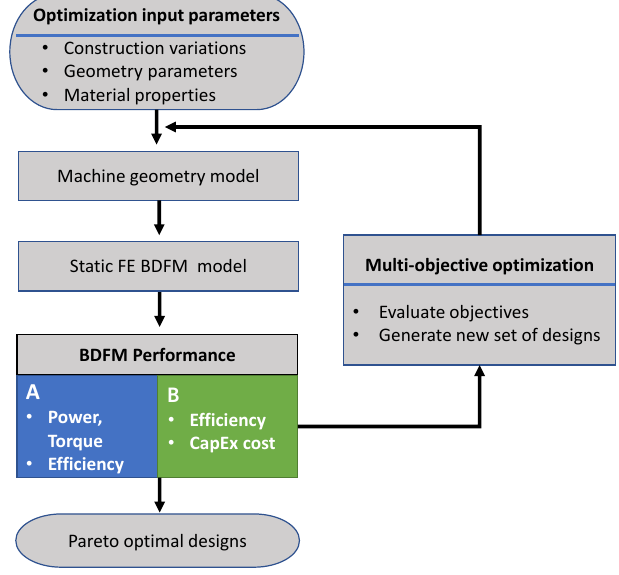
Figure 14. NSGA-II optimizations flow chart. Optimization processes in